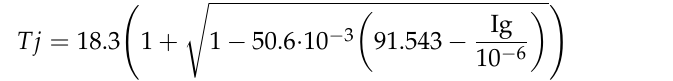
Figure 19. Cooling curves of I g.